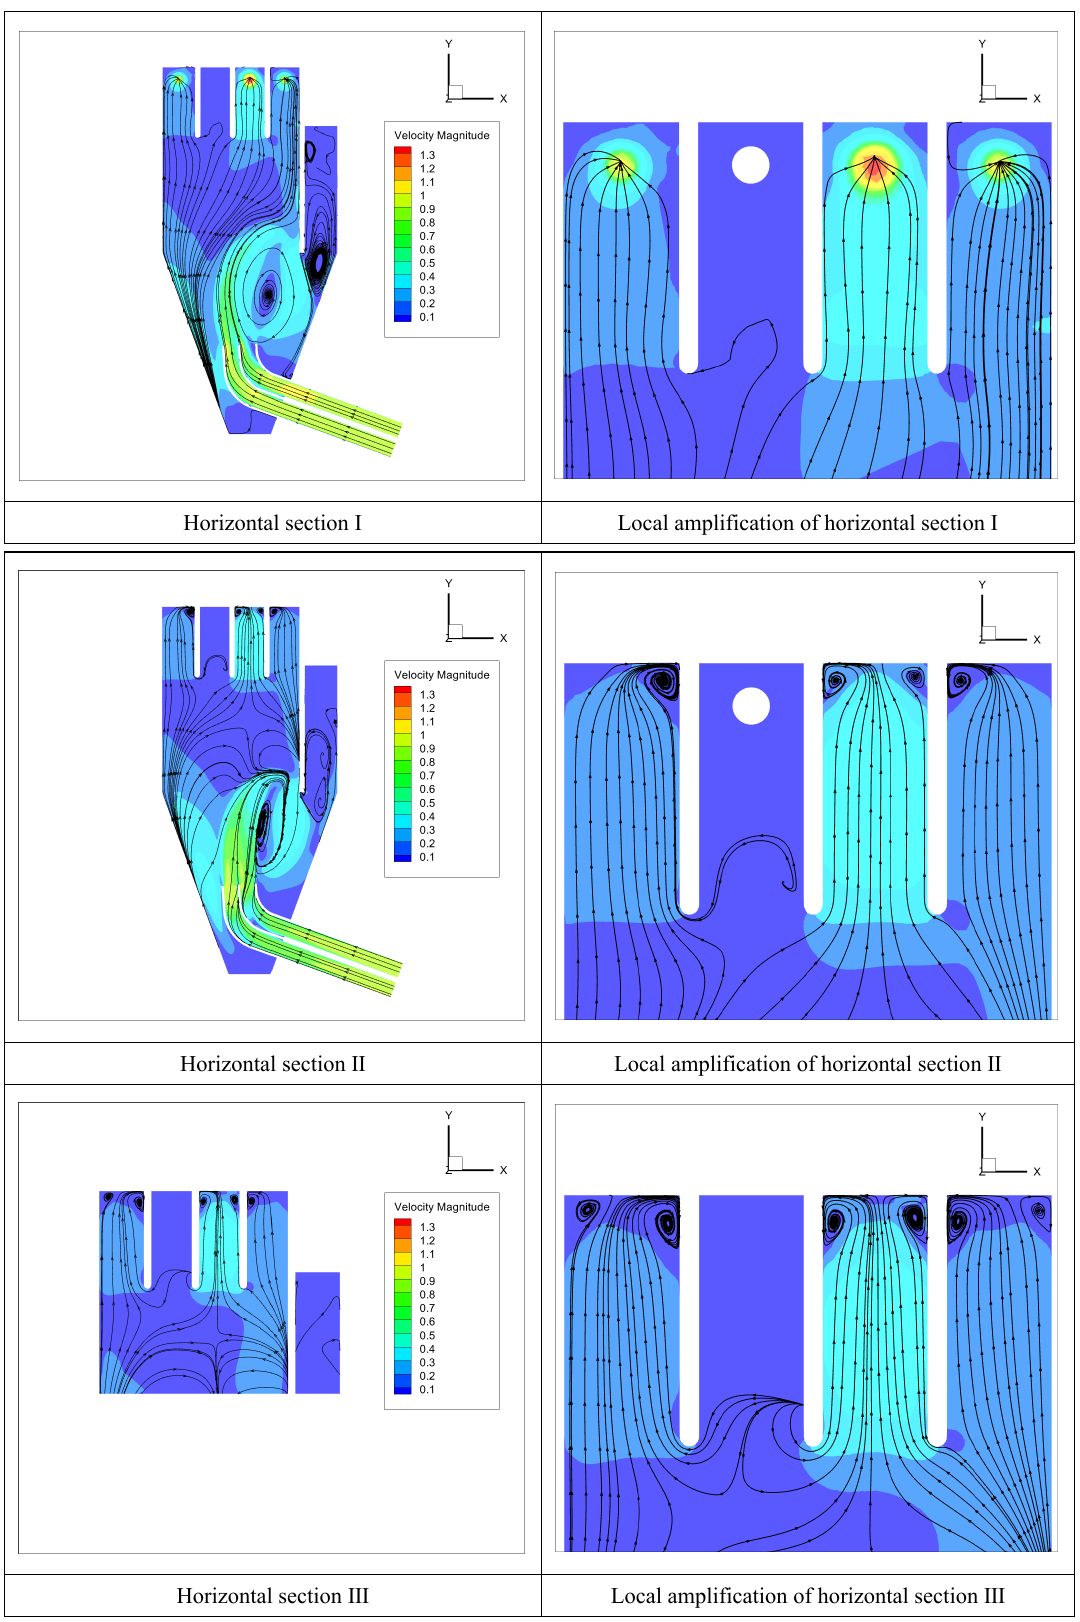
Figure 8. Flow pattern for the optimal scheme of the diversion piers for operating pumps 1, 2, and 4.